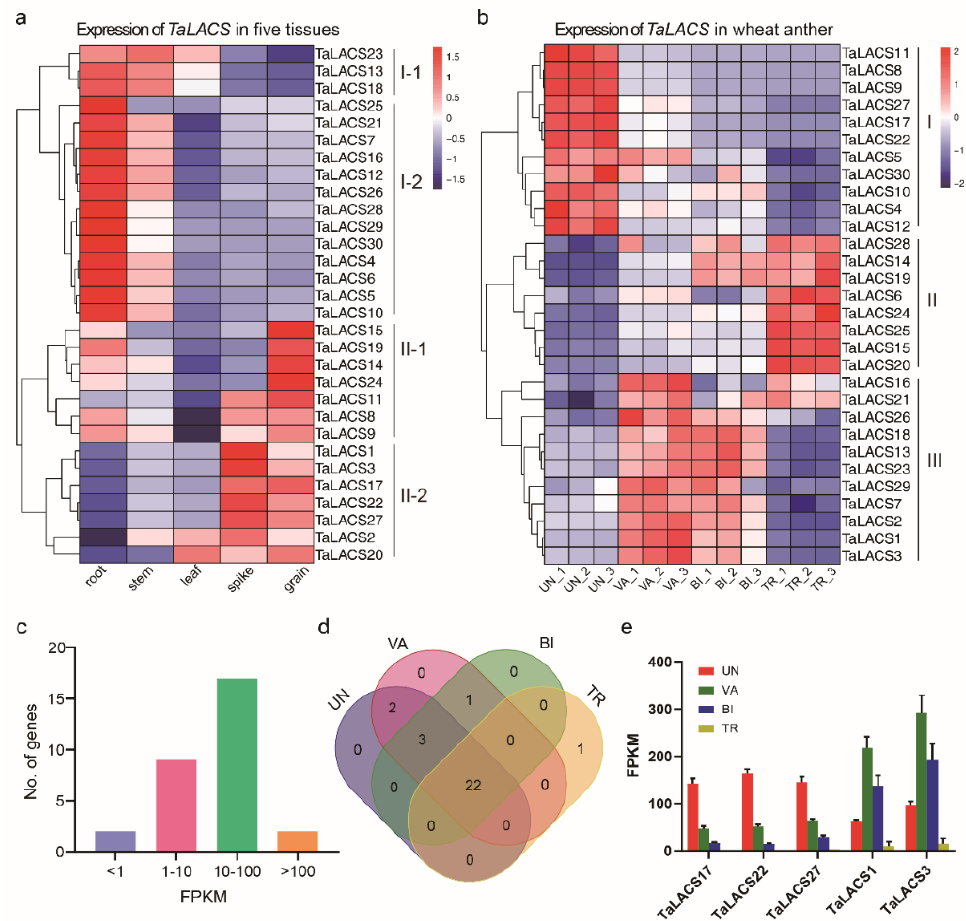
Figure 5. Expression of TaLACSs in wheat. ( a ) Expression heatmap of TaLACSs in five wheat tissues. ( b ) Expression heatmap of TaLACSs genes in wheat anthers. ( c ) The expression range of TaLACSs in wheat anther at four stages. ( d ) Venn diagram of TaLACSs with expression level higher than 1 FPKM in wheat anthers. ( e ) The expression of the top five expressed TaLACSs in wheat anthers. UN, uninucleate stage; VA, vacuolated stage; BI, binucleate stage; TR, trinucleate stage.